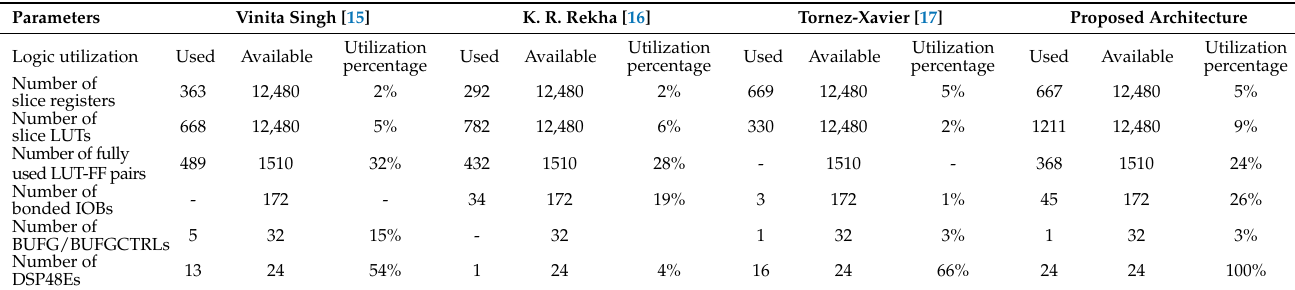
Figure 11. Block diagram of 2 × 2 neural network. Table 1. Comparison of proposed architecture with existing architecture.